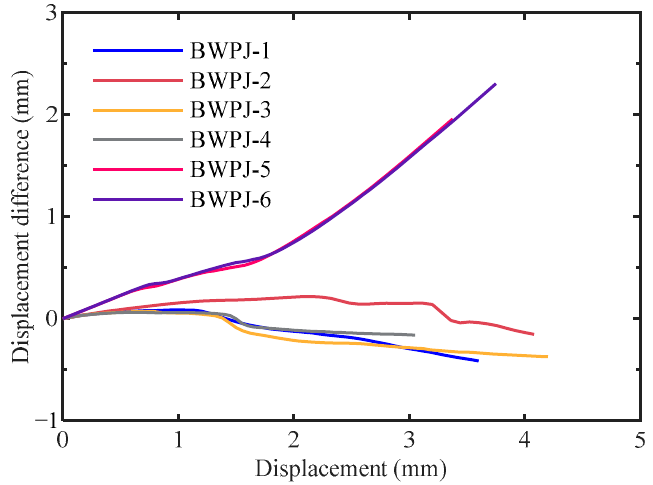
Figure 13. Displacement difference between the center of the end plate and the concrete wall surface.